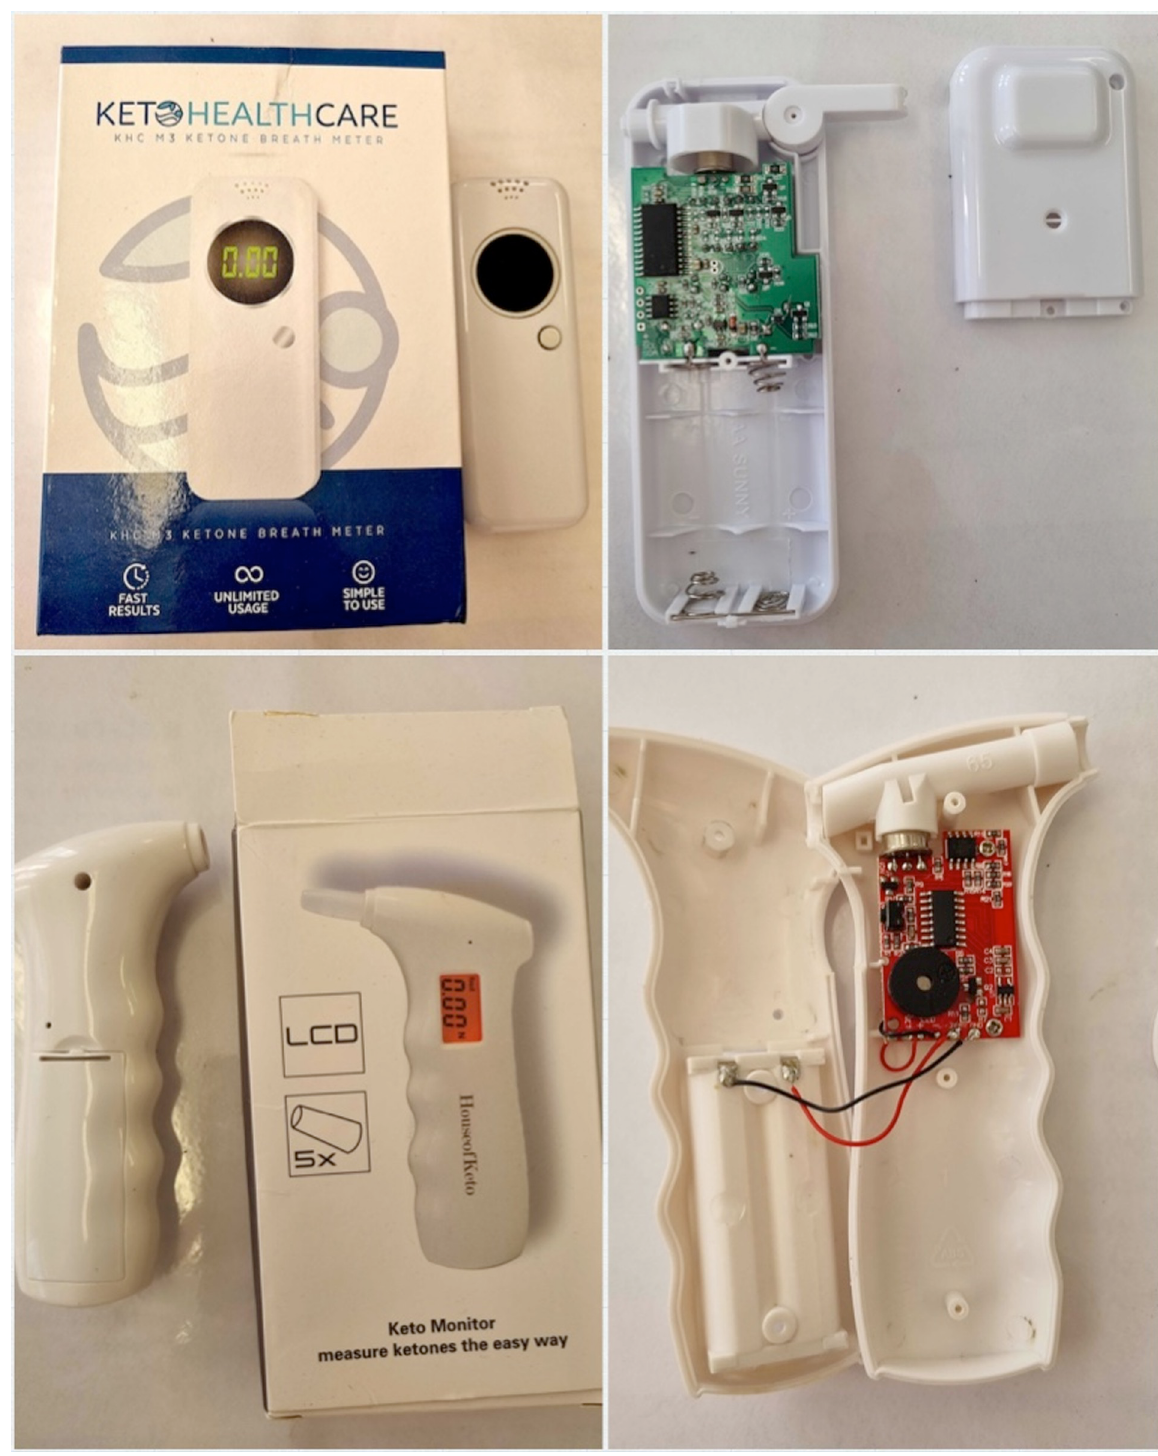
Fig 1. Tested breath ketone sensor devices. Note . The size of the required AA batteries displays the sensor sizes in the images of unassembled sensors.